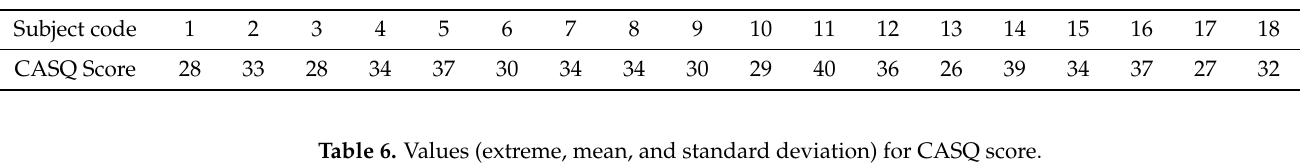
Table 5. Values for CASQ score.